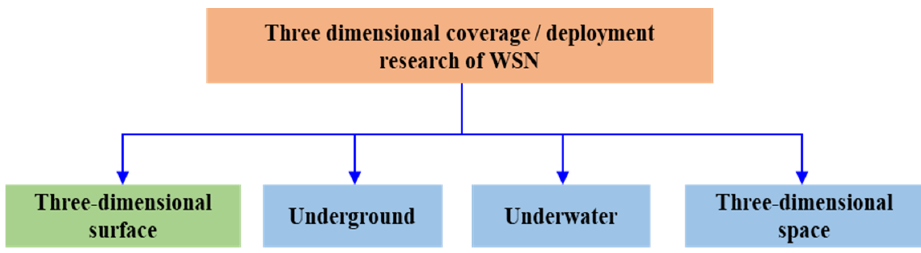
Figure 1. Three-dimensional node coverage/deployment problem.